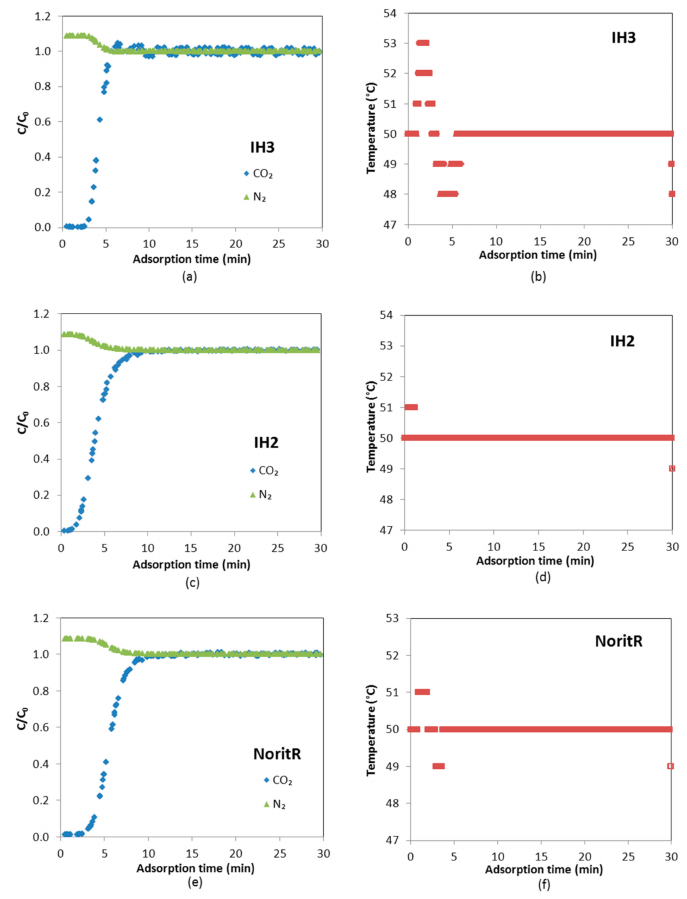
Figure 8. Comparison of N 2 and CO 2 concentration profiles during the binary experiments with a CO 2 /N 2 mixture (8/92 vol %) for: ( a ) IH3; ( c ) IH2; and ( e ) Norit R at 50 ◦ C for the consecutive cycles; and thermal wave observed during the adsorption step for samples: ( b ) IH3; ( d ) IH2; and ( f ) Norit